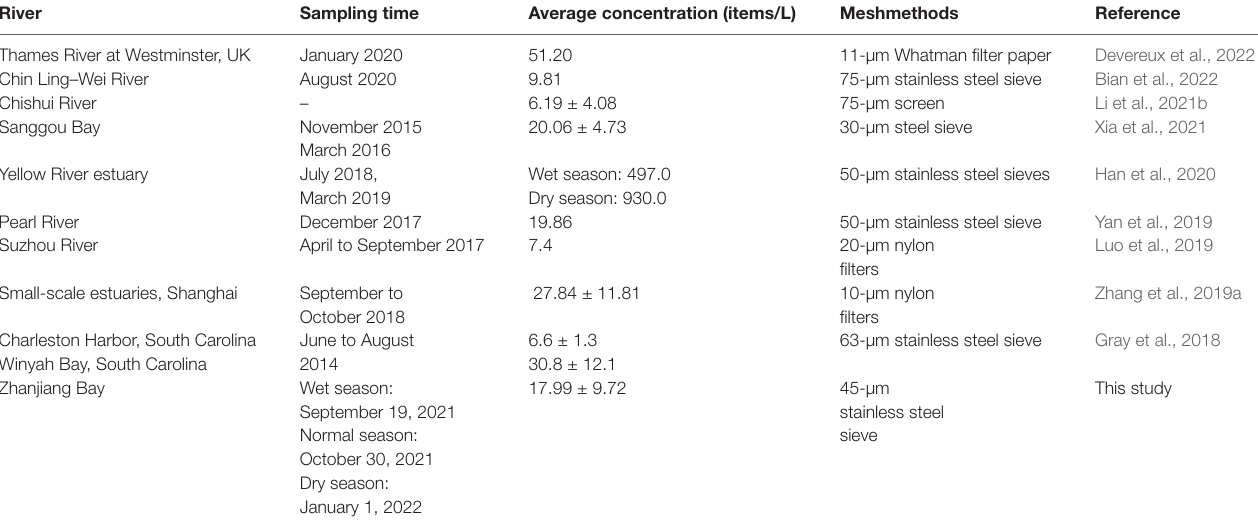
TABLE 2 | Comparison of the abundance of MPs in ZJB with other rivers and